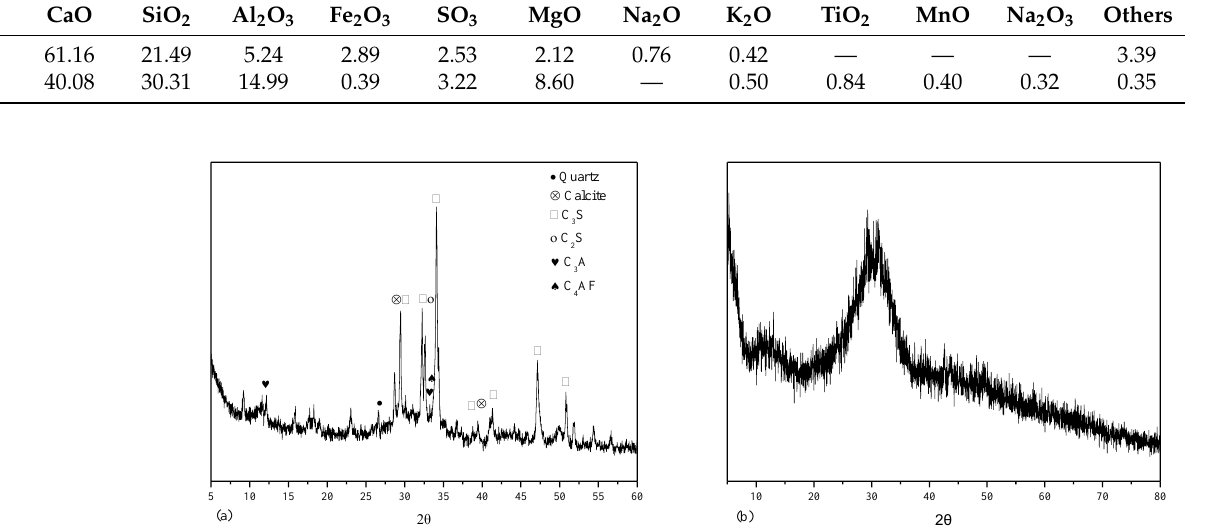
Figure 1. The phase composition of raw materials: ( a ) cement; ( b ) slag.